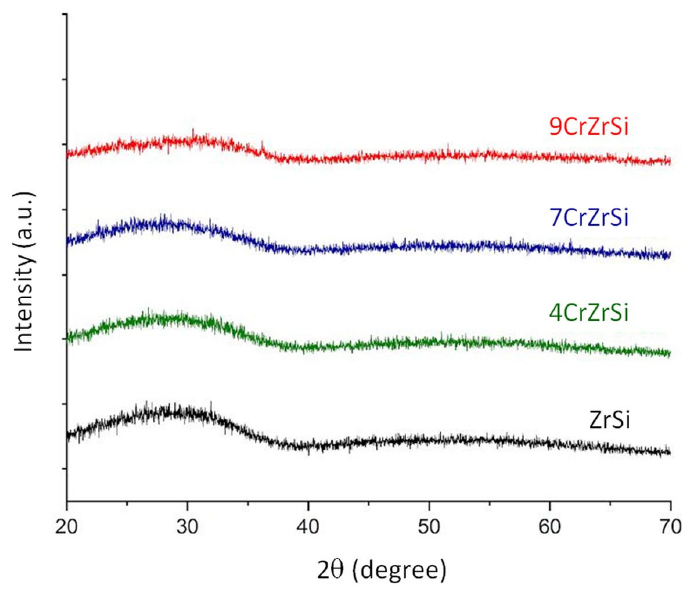
Figure 2. XRD patterns of fresh ZrSi and CrZrSi catalysts.